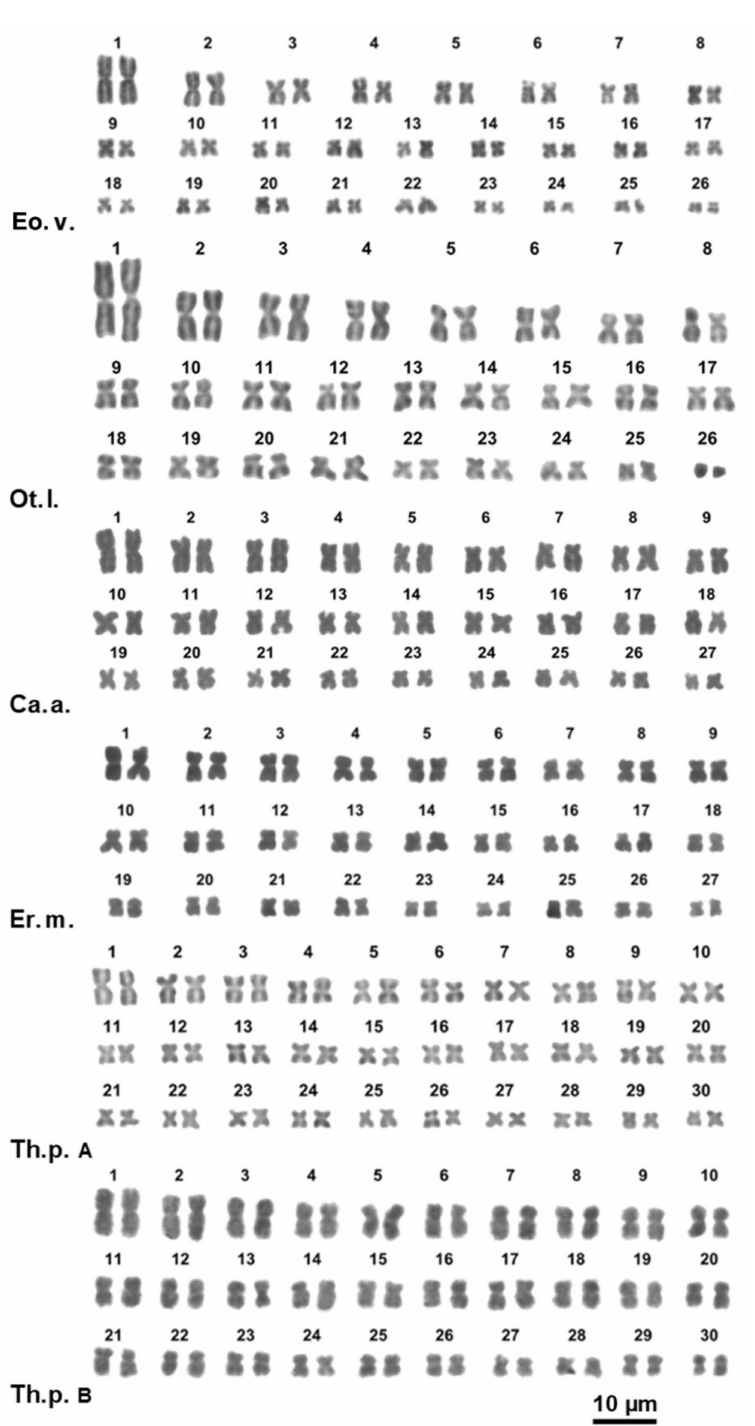
Figure 2. Giemsa-stained karyotypes of Eobania vermiculata (Eo.v.), Otala lactea (Ot.l.), Cantareus apertus (Ca.a.), Erctella mazzullii (Er.m.), Theba pisana from Fusaro lake (Th.p. A), Theba pisana from Messina (Th.p.